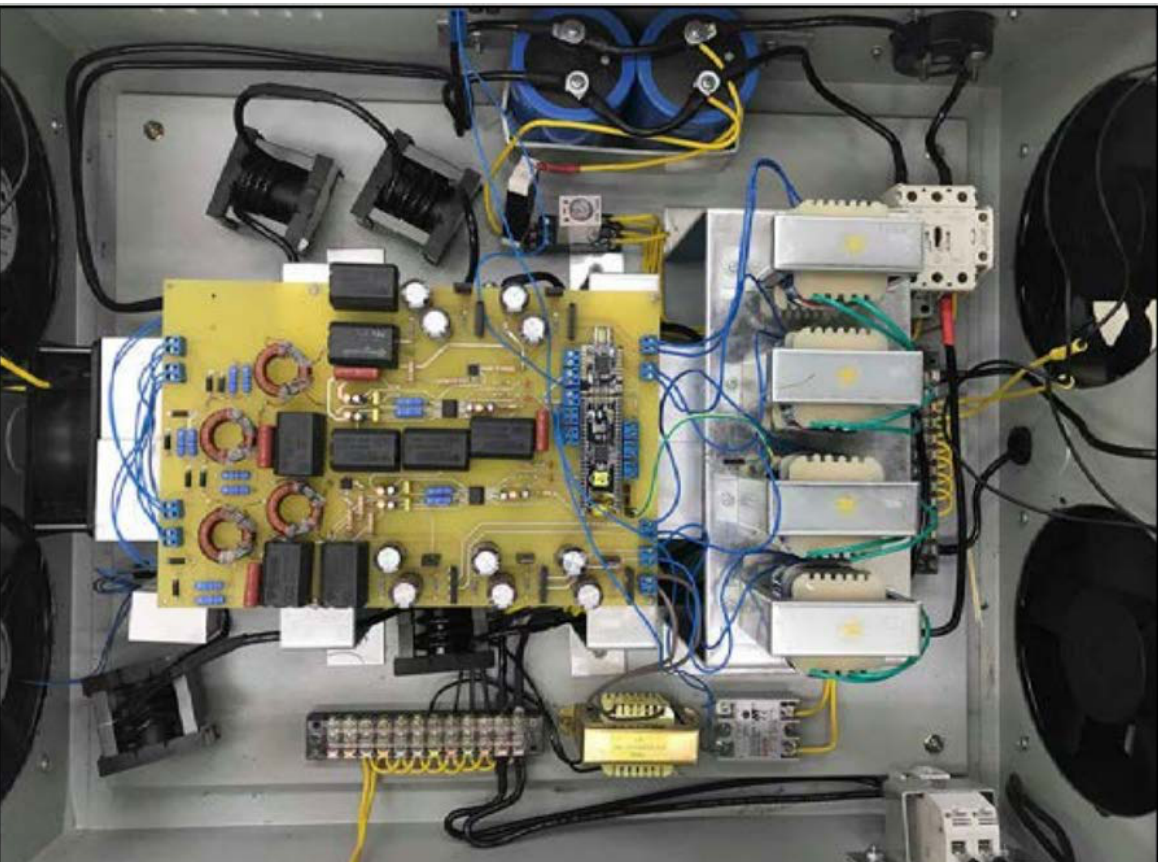
Figure 1. Block diagram of the thermal induction circuit.